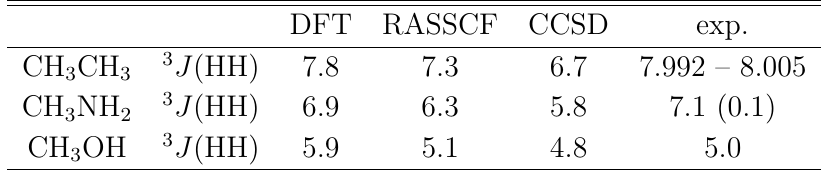
Table 5: Comparison of the total vicinal coupling constants calculated at the DFT, RASSCF a and CCSD levels with experiment. b